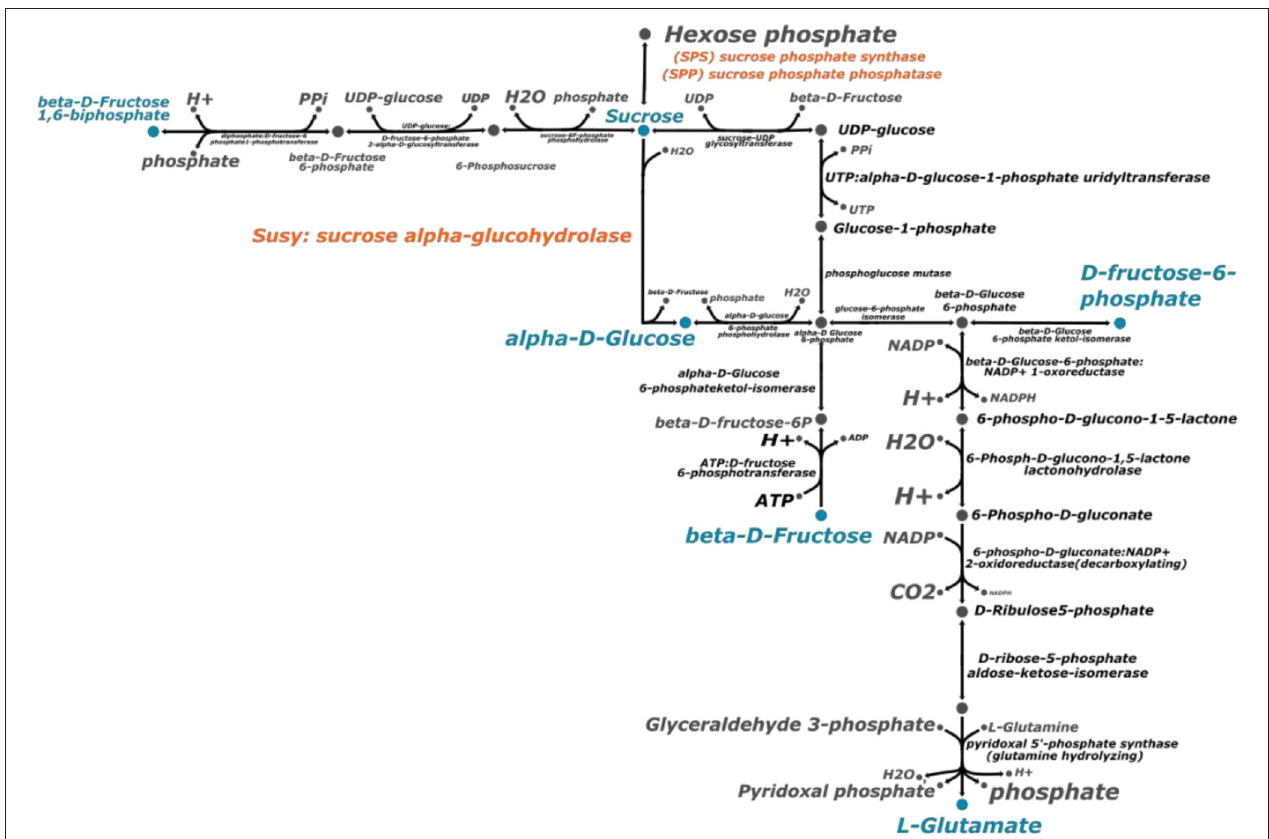
FIGURE 4 | Sucrose biosynthesis metabolic pathway. This metabolic pathway was predicted with the ModelSEED reconstruction server (Seaver et al., 2020). The process to reconstruct the metabolic pathway was repeated with the genome of Saccharum spontaneum and Sorghum bicolor. The enzymes in orange color are the ones related directly with sucrose biosynthesis. The metabolites highlighted in blue color represent the connection with other metabolic pathways.